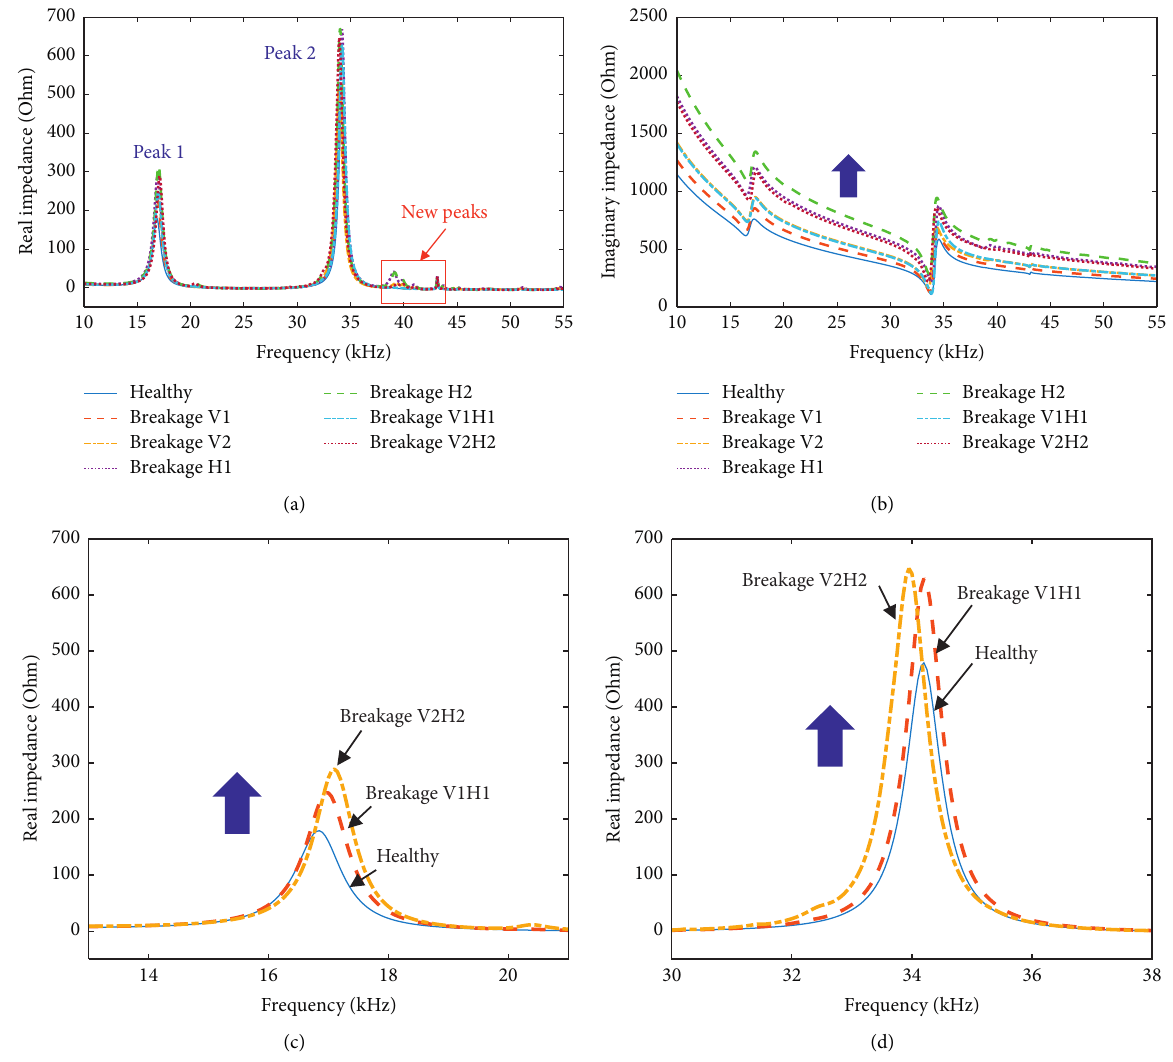
Figure 22: Numerical EMI responses under PZT breakage defects. (a) Real part. (b) Imaginary part. (c) Peak 1 (Cases: V1H1, V2H2). (d) Peak 2 (Cases: V1H1,